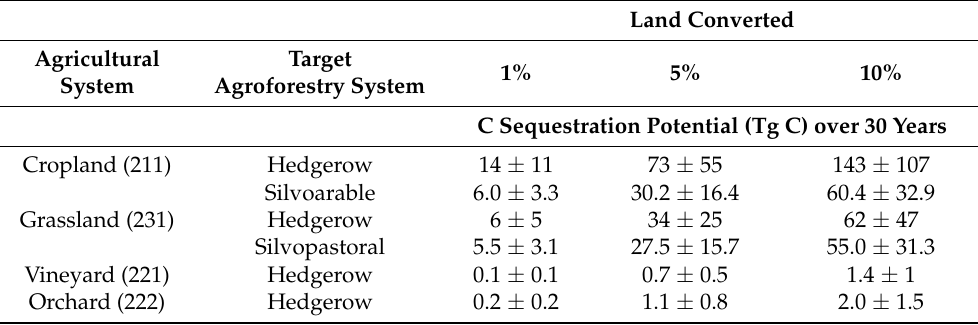
Table 4. Carbon sequestration potential (in total biomass carbon and soil organic carbon) in Germany for three land conversion scenarios (mean ± 95% CIs; from [26]). Numbers refer to CORINE codes. Land